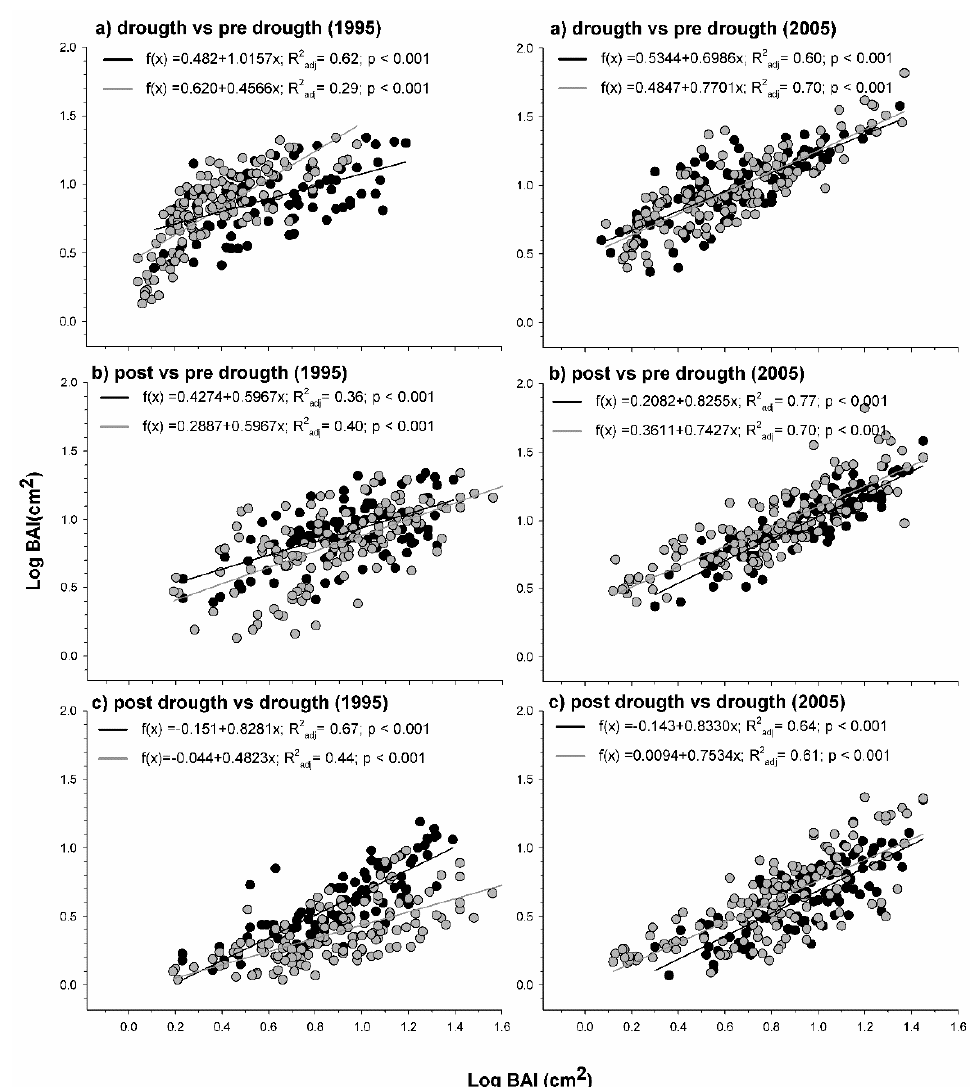
Figure 3. Relationships among the log-transformed basal area increments before ( a ), during ( b ), and after ( c ) two important droughts (1995, 2005) for the study period. The regression and correlation coe ffi cients, associated significance levels, and the regression lines are also represented. The distinct colors correspond to natural forest (black) and planted trees (grey).